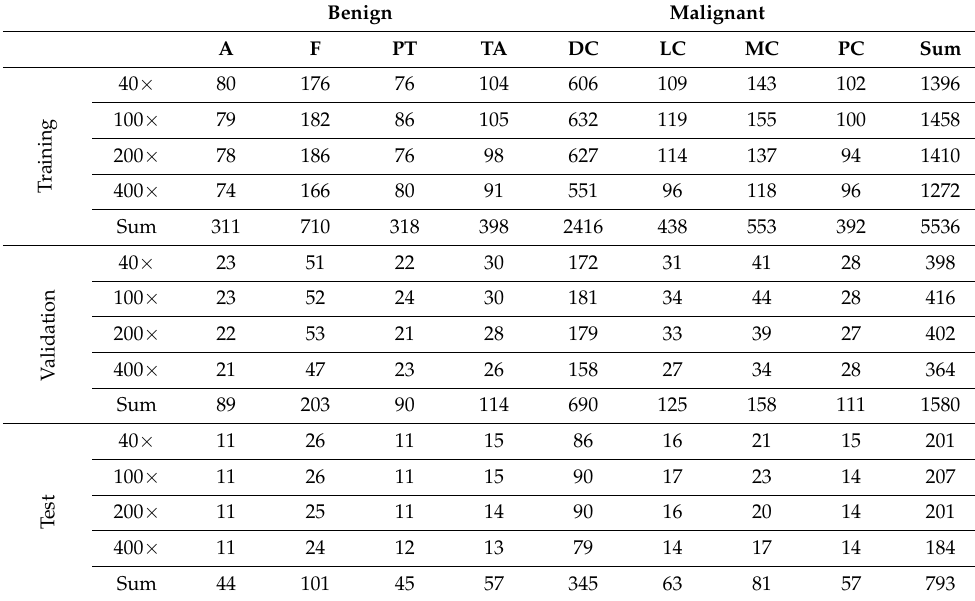
Table 3. Distribution of data in the training, validation, and test datasets. Benign